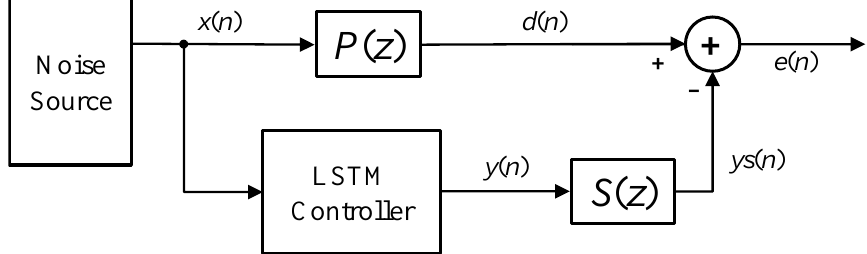
Figure 3. Block diagram of deep neural network filters with long short-term memory (LSTM) for the ANC system. Compared with the conventional FxLMS system, the blocks corresponding to the FxLMS algorithm have been replaced with the LSTM controller block.